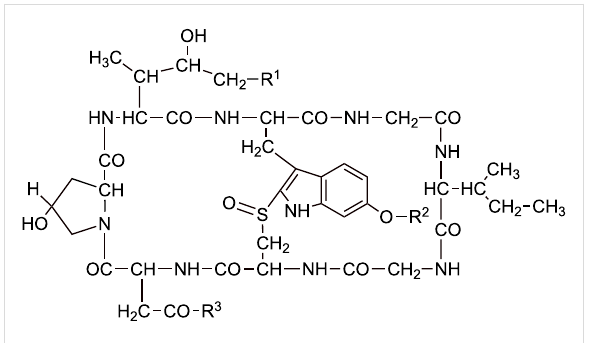
Figure 7: Chemical structure of amanitin with attachment site for conjugation to internalization-mediating moieties (R 1 , R 3 ).